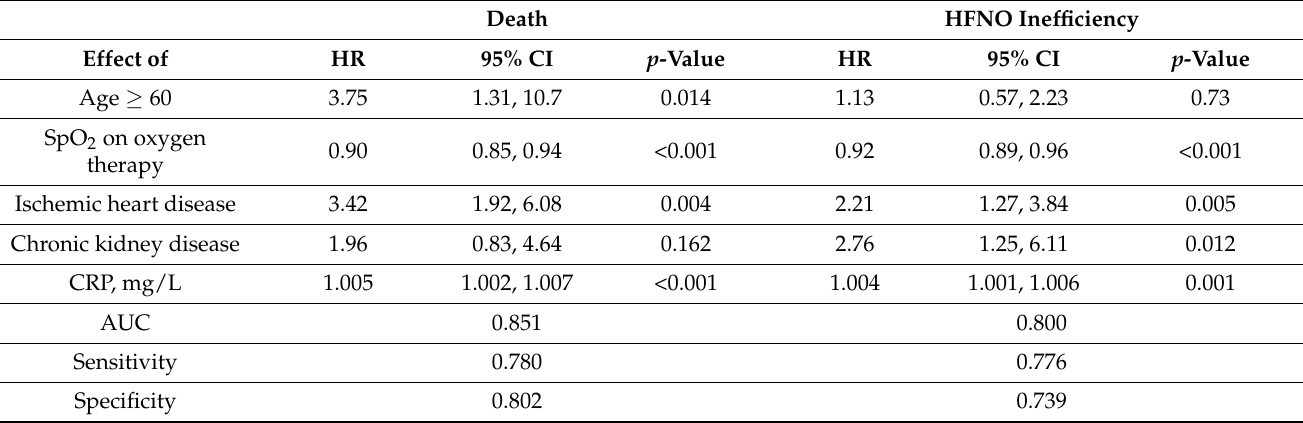
Table 5. Analysis of effect of SpO 2 with oxygen therapy on risk of death and HFNO inefficiency in a multifactor logistic regression model. Death HFNO